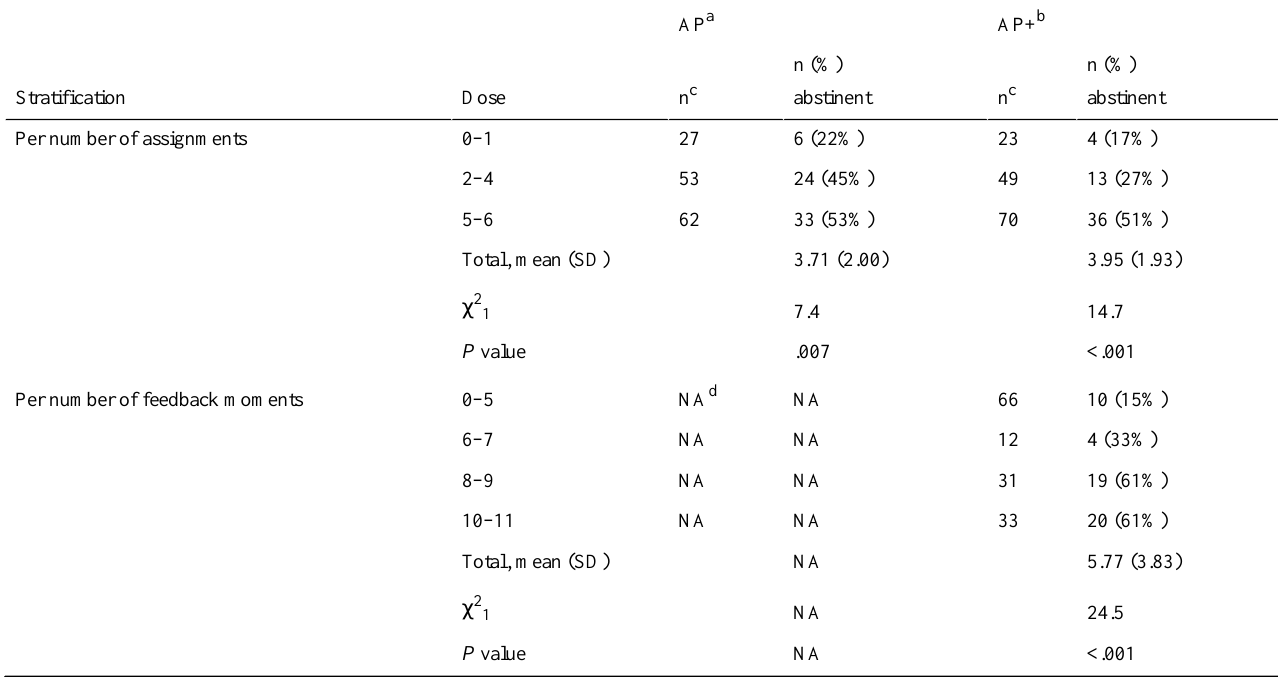
Table 4. 12-month continued abstinence rates stratified by the number of planning assignments and feedback moments in the modified sample (sample